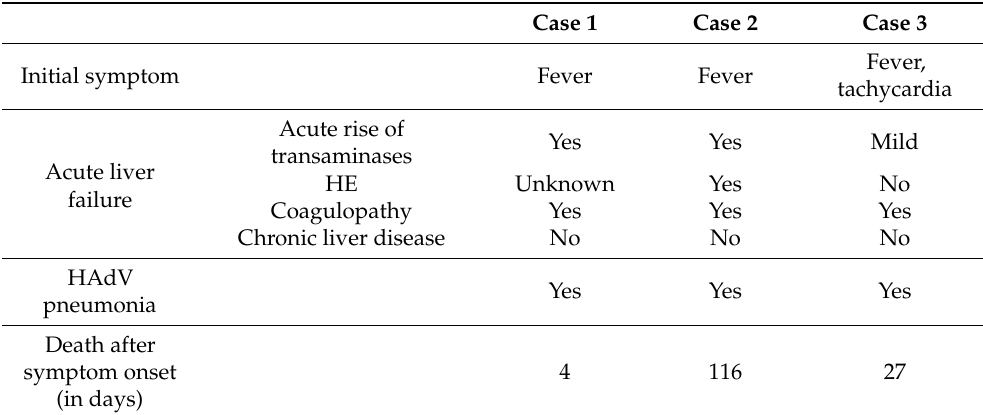
Table 5. Clinical